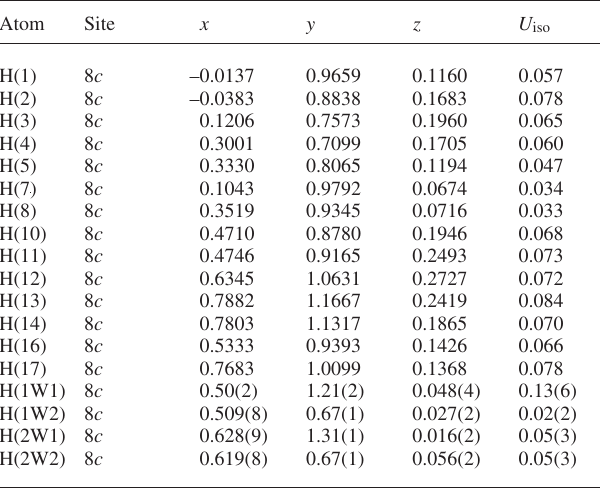
Table 2. Atomic coordinates and displacement parameters (in Å 2 )